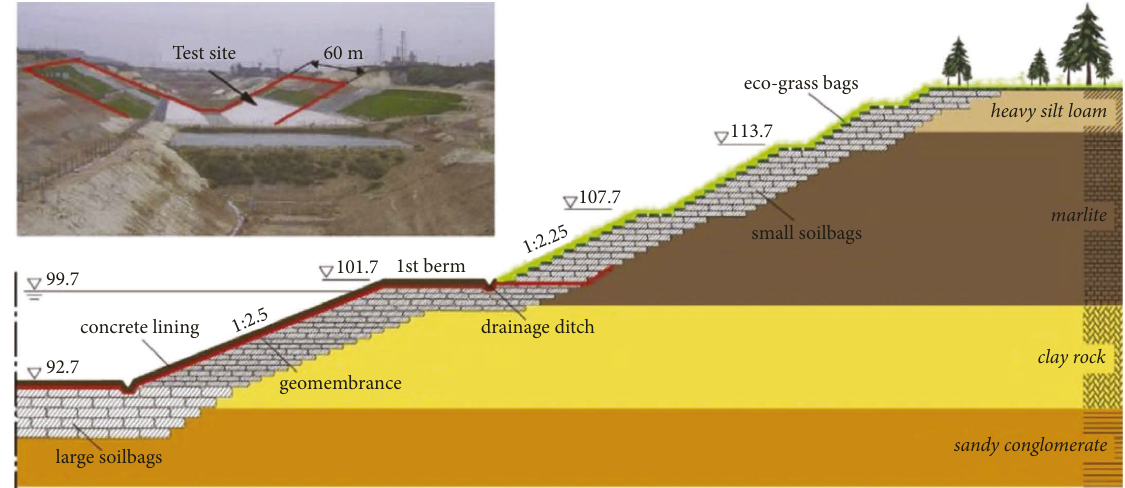
Figure 15: Treatment of expansive soil/rock channel slopes with soil